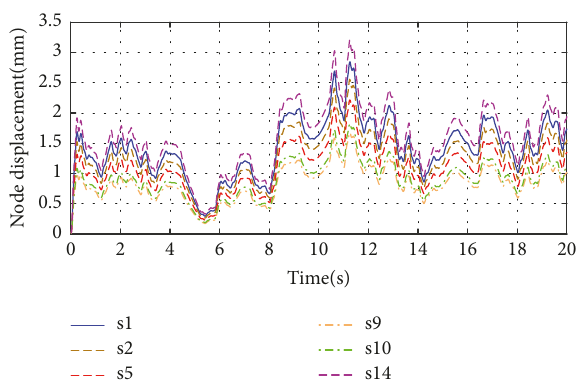
Figure 13: The nodal displacement with considering the load modeling error.